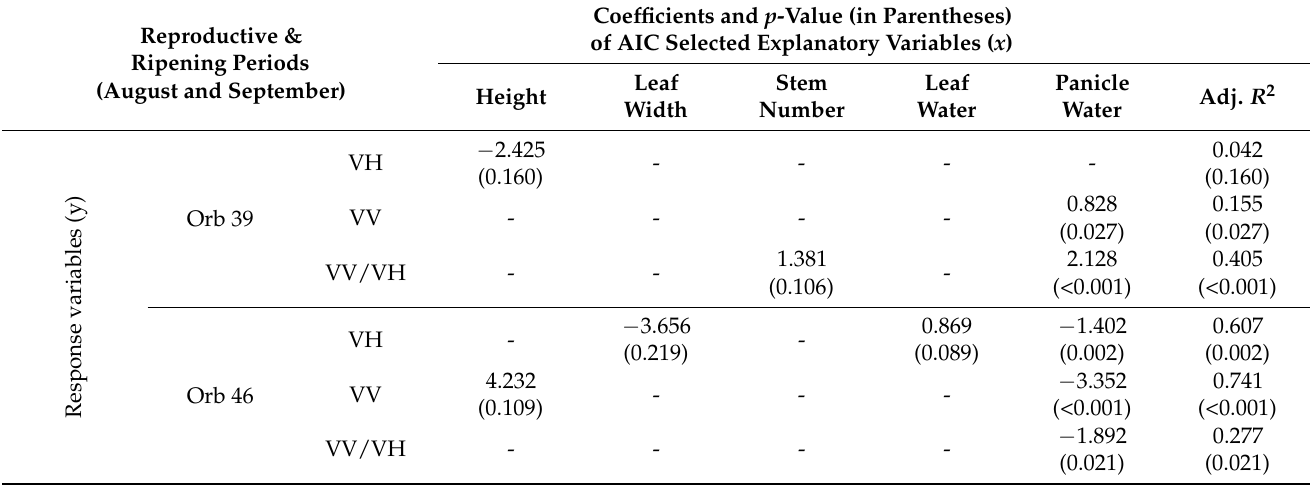
Table 3. Results of the multivariate linear regression analysis. Selected variables are shown with coefficients and p -values in parenthesis; a hyphen “-” indicates that the variable is not selected by the AIC method. The overall accuracy of the selected model was evaluated with Adj. R 2 and p -value are shown in parenthesis. Data in orb 39 (ascending) and 46 (descending) were analyzed separately for the reproductive and ripening periods (August and